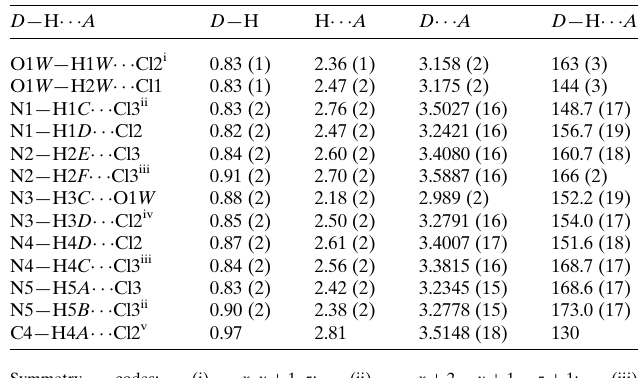
Table 1 Hydrogen-bond geometry (A˚ , (cid:5) ).